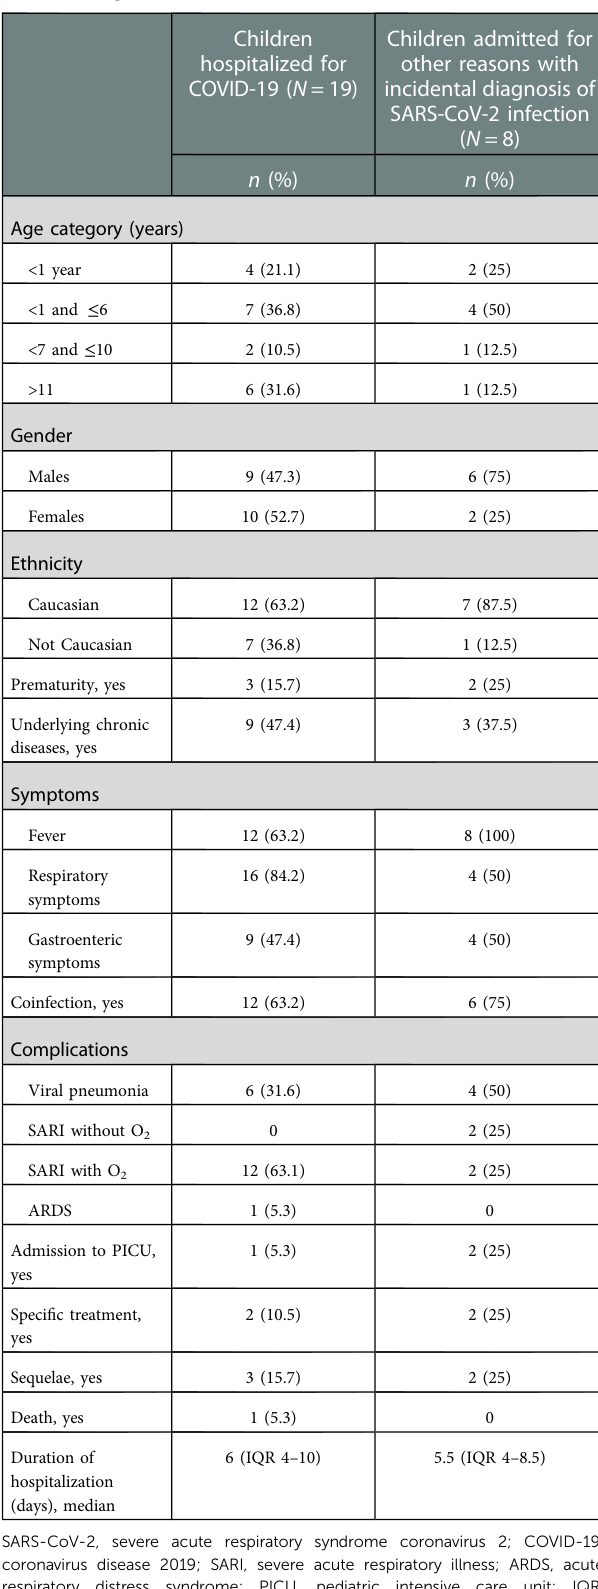
TABLE 3 Characteristics of children who developed complications and hospitalized with COVID-19 or admitted for other reasons and with incidental diagnosis of SARS-CoV-2